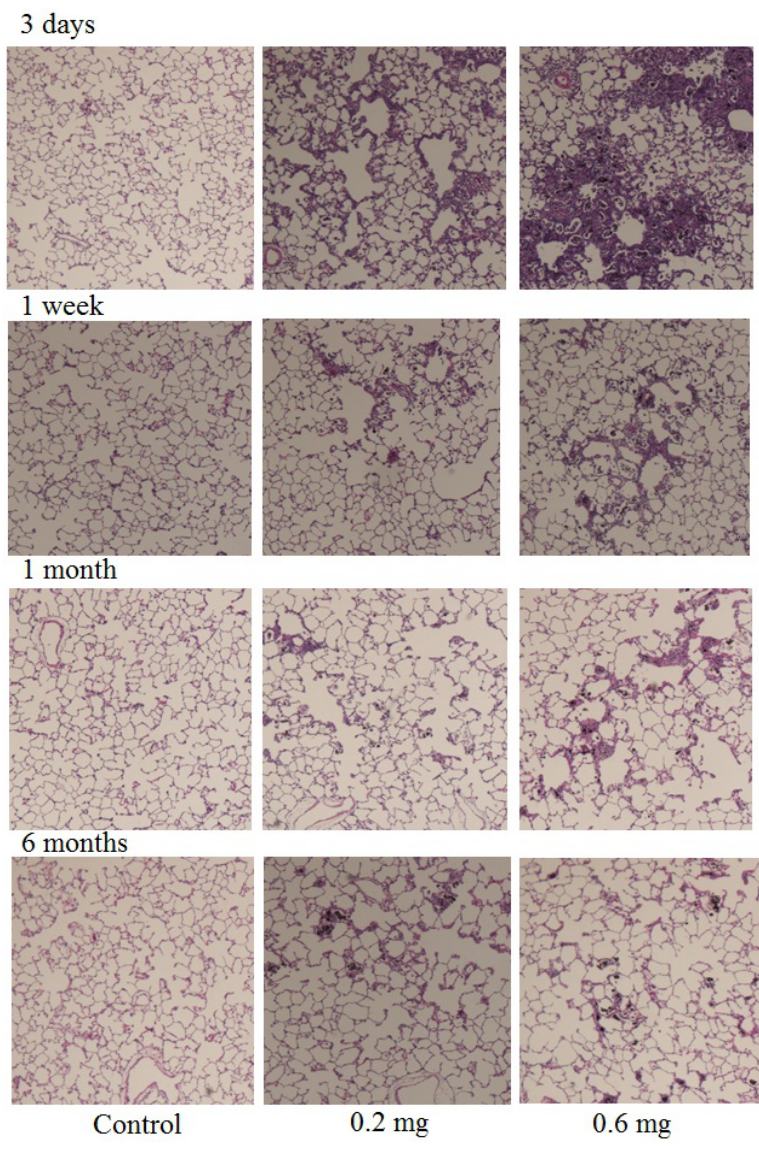
Figure 5. HE staining of lung sections exposed to MWCNT after intratracheal instillation. Control (0.05% of Triton X-100), low dose (0.2 mg) and high dose (0.6 mg) sections at 3 days, 1 week, 1 month, and 6 months after instillation were